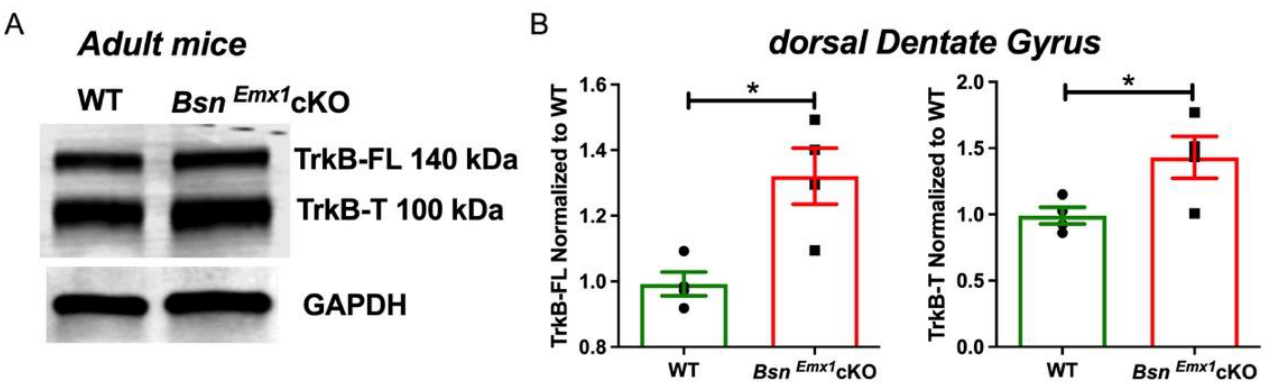
Figure 1. Elevated TrkB levels in the dorsal DG of adult Bsn Emx1 cKO mice (~3–5 months-old). ( A ) Representative western blots of TrkB full length (FL) at ~140 kDa, TrkB truncated (T) form at ~100 kDa and GAPDH, loading control. ( B ) Quantifications of both TrkB isoforms reveals elevated TrkB levels in Bsn Emx1 cKO (N = 4 mice) dorsal DG compared to WT mice (N = 4 mice). * indicates a signif- icant genotype effect (* p < 0 .05), Student’s t test. All values are expressed as mean ± SEM.